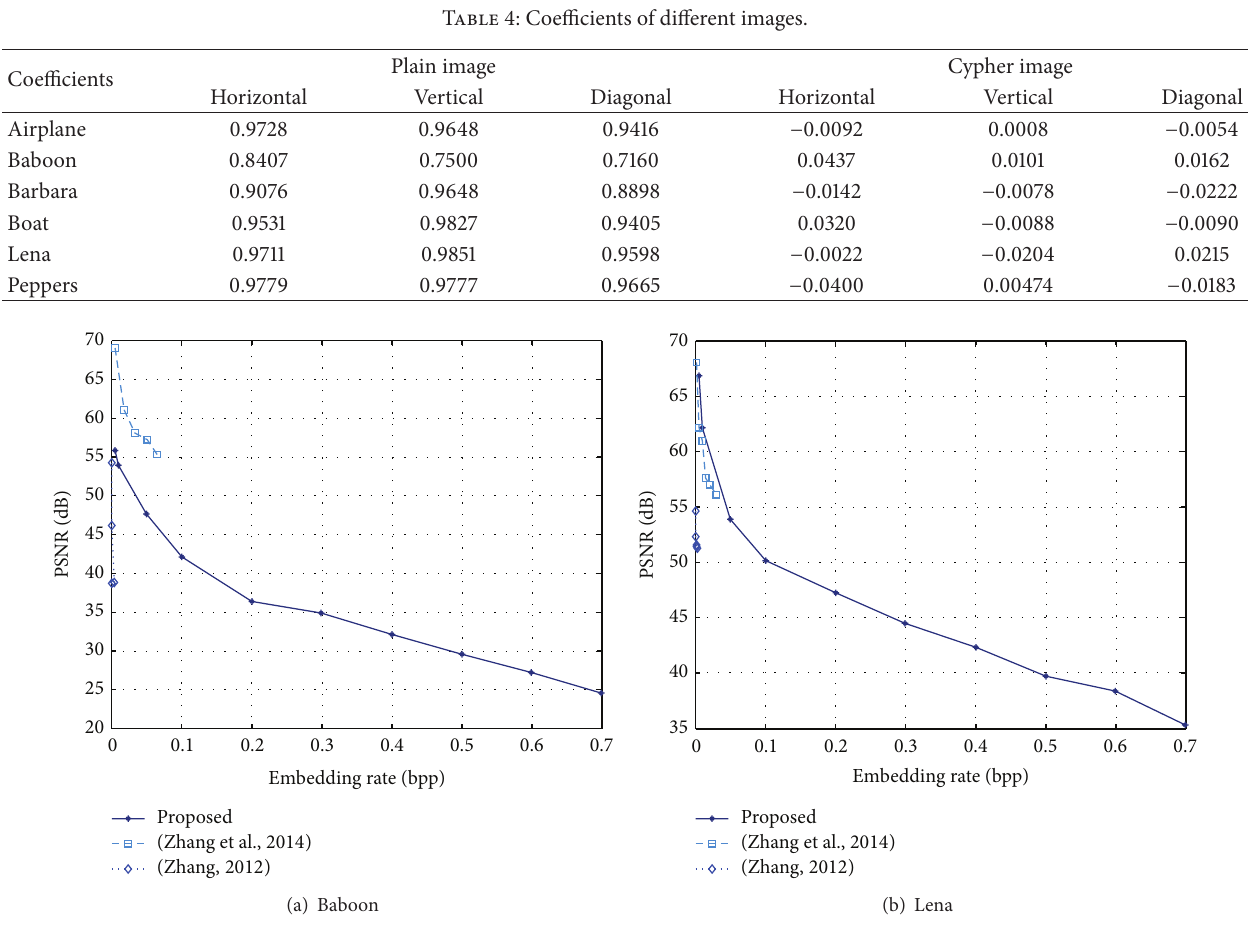
Figure 7: Comparisons of embedding rate and PSNR with existing schemes.